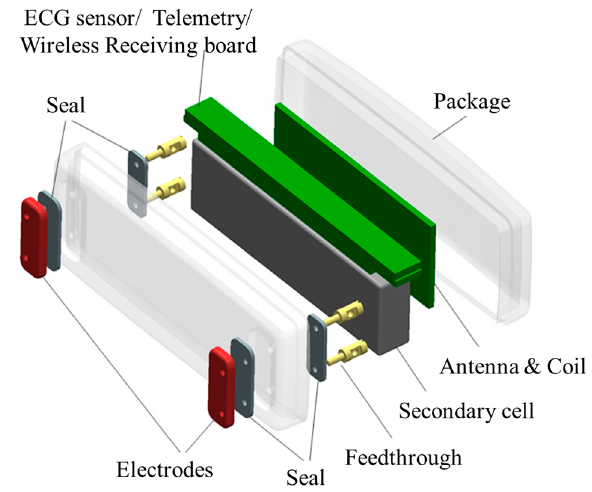
Figure 6. Configuration of the implantable device.